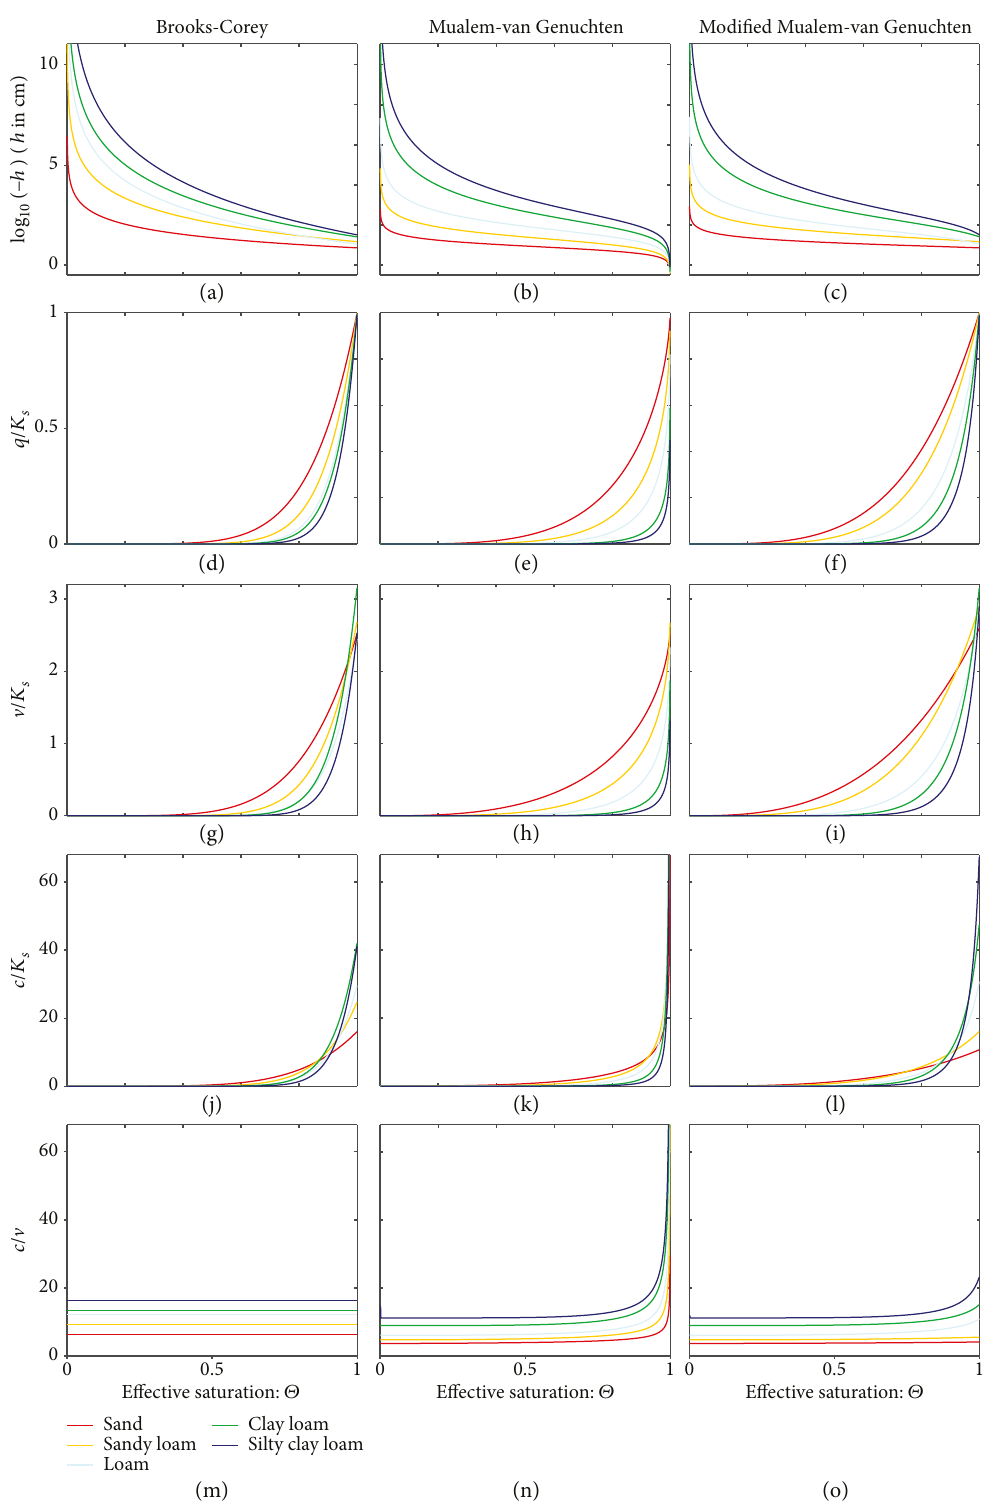
Figure 2: Constitutive relations of the e ff ective saturation to logarithmic pressure head (a – c), dimensionless speci fi c discharge (d – f), dimensionless average pore water velocity (g – i), dimensionless celerity (j – l), and kinematic ratio (m – o) in 5 typical soils under models of Brook-Corey, unmodi fi ed Mualem-van Genuchten, and modi fi ed Mualem-van Genuchten (illustrated in each